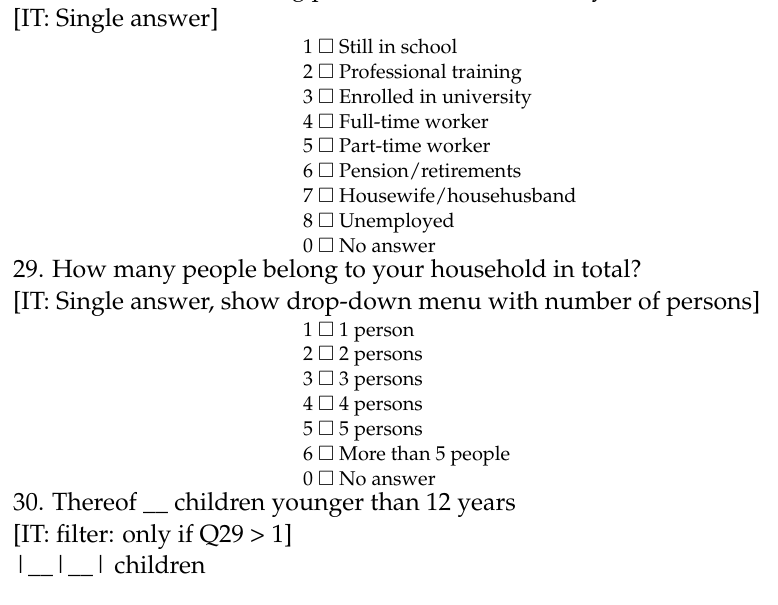
Table A1. 20 choice